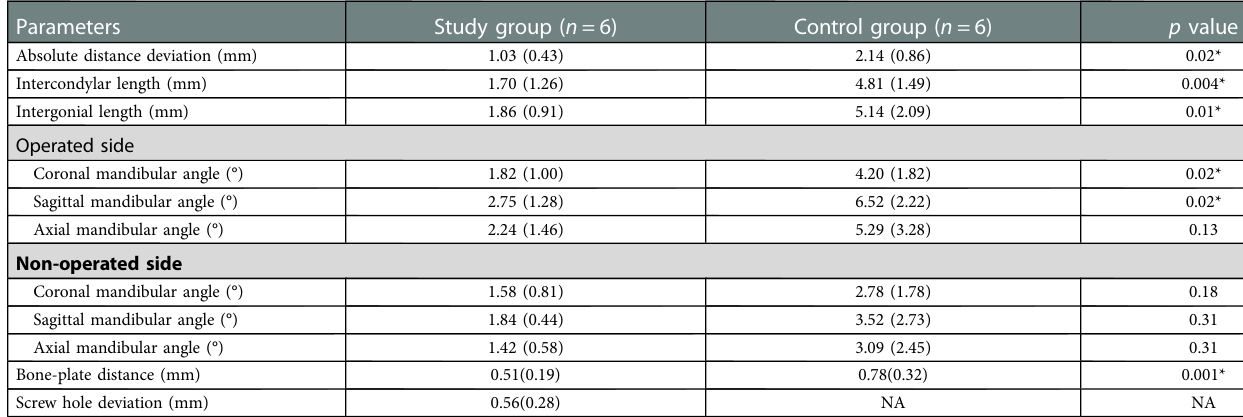
TABLE 1 Spatial deviations of CAMR in the study and control